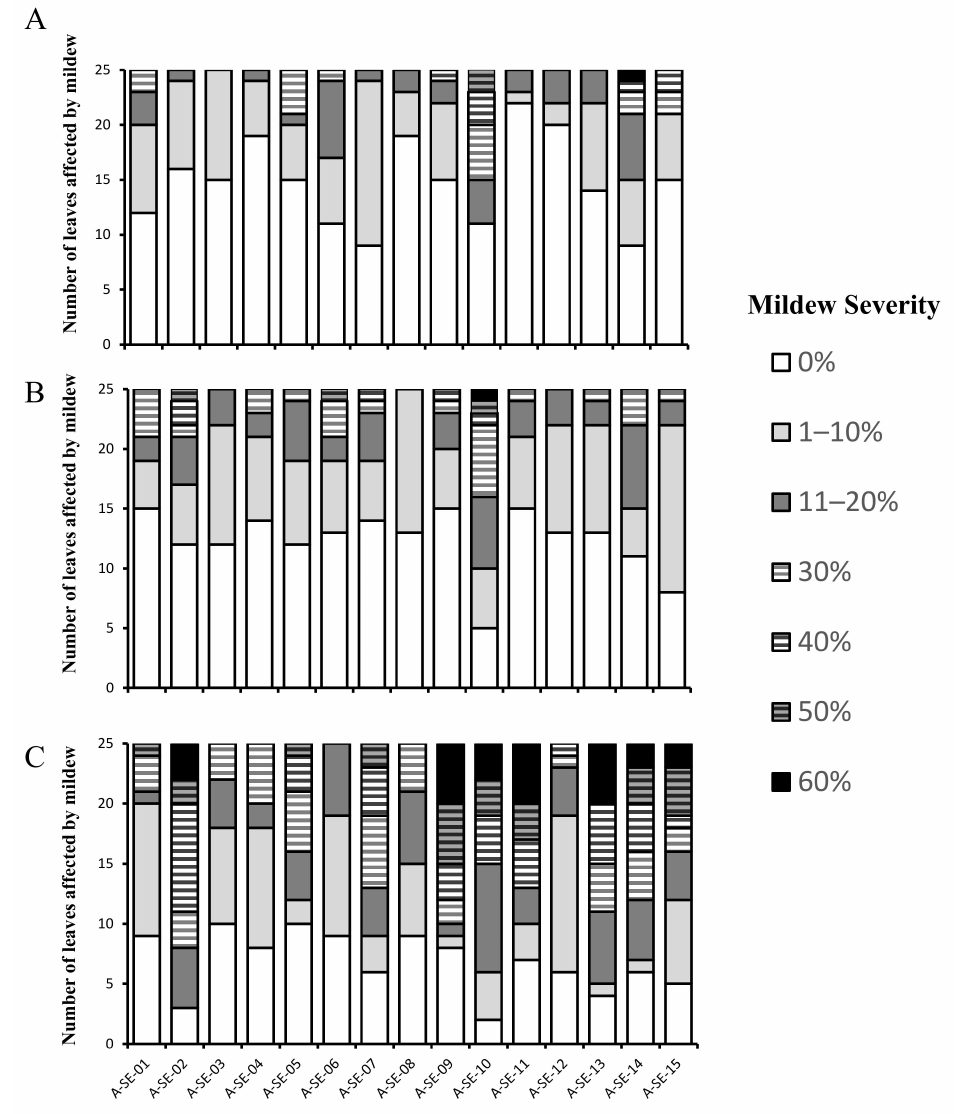
Figure 3. Mildew incidence and severity. Mildew incidence and severity were determined as described in the Methods section. Mildew severity degreewas expressed as the percentage (%) of leaf affected by the pathogen (leaf area converage of 0%, 1–10%, 11–20%, 30, 40%, 50%, or more than 60%). Mildew incidence and severity were evaluated at different developmental stages: at ( A ) 82 days after sowing (d.a.s.) (upper panel), ( B ) 100 d.a.s. (middle panel), and ( C ) 128 d.a.s (bottom